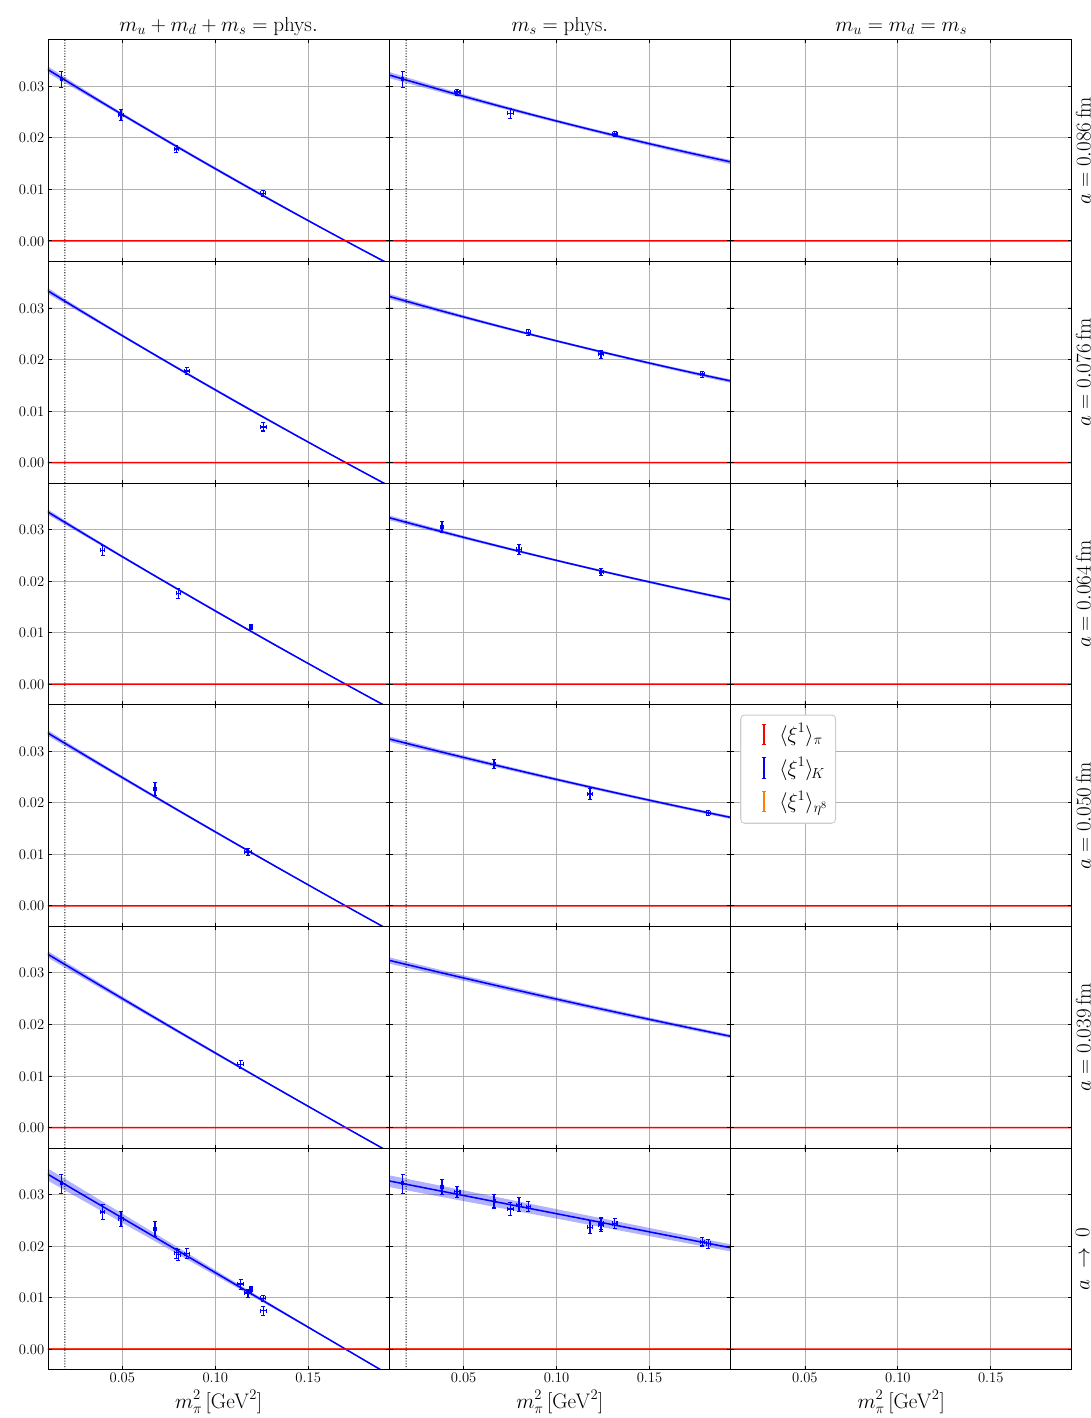
Figure 13 . The pion mass dependence of the moments all lattice spacings as well as in the continuum limit (where, for illustrative purposes, all points have been translated along the fitted function). The columns correspond to the three quark mass trajectories, cf. figure 2. The dotted gray lines mark the physical meson masses. Due to symmetry, this moment vanishes exactly for the π and η 8 mesons as well as on the symmetric